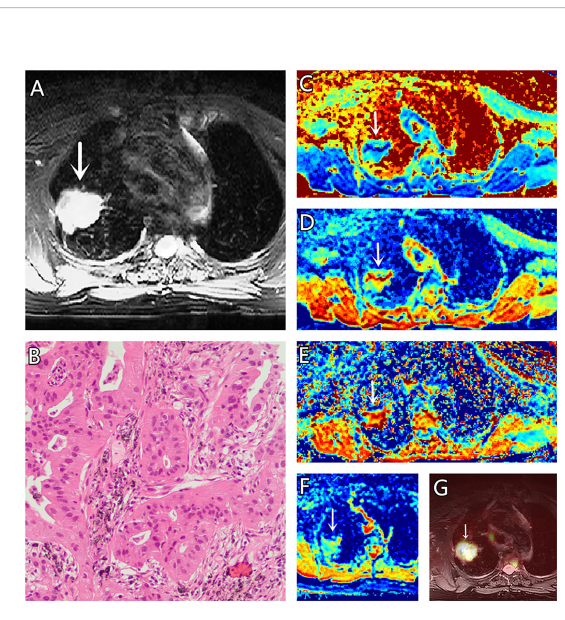
FIGURE 2 (A – G) A 73-year-old female patient, with adenocarcinoma (AC) in the right lung, (A) is T2 weighted anatomic image, (B) is hematoxylin and eosin (H&E) staining image which con fi rms this lesion to be AC, (C) is m map with m = 4.77 m m, (D) is D map with D = 1.69 m m 2 /ms, (E) is b map with b = 0.83, (F) is ADC map with ADC = 1.37 m m 2 /ms, (G) is the fusion image of the SUV map and the attenuation correction map with SUVmax =